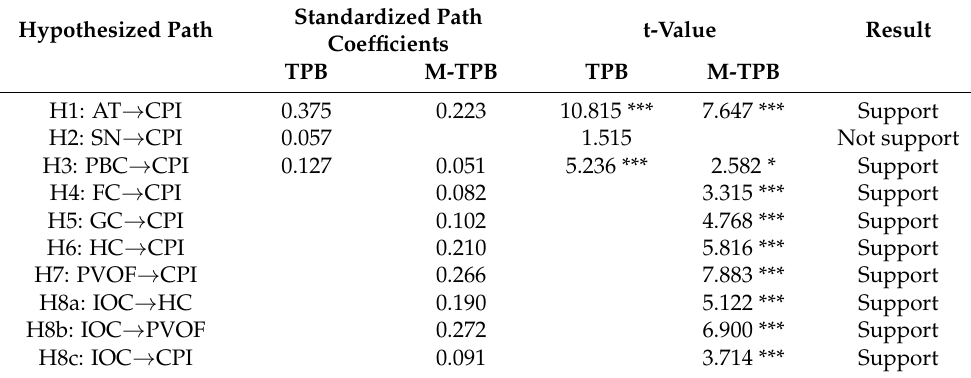
Table 6. Hypotheses test